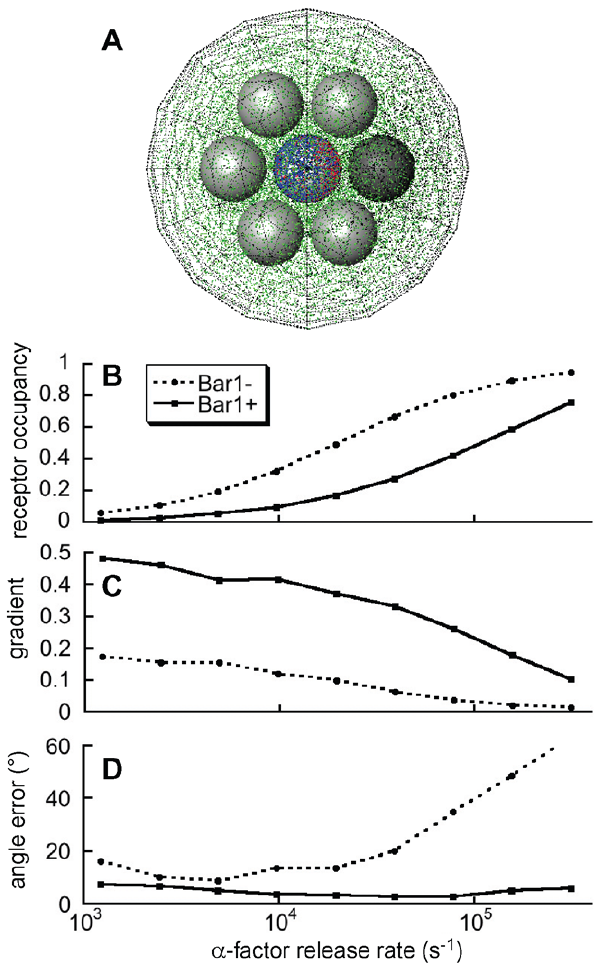
Figure 4. A model of the effect of the Bar1 protease on yeast signaling. (A) A snapshot of the system shown at steady state and with a target cell release of about 4 6 10 4 a -factor molecules per second. It is surrounded by a triangulated spherical boundary which absorbs molecules with Smoldyn’s ‘‘unbounded-emitter’’ method. The central sphere is a MAT a cell, light grey spheres are challenger MAT a cells, and the dark grey sphere on the right is the target MAT a cell. Blue dots are unliganded GPCRs, red are GPCR- a complexes, green are Bar1 molecules, and black are a -factor molecules. Model details are presented in Text S4. (B) Average receptor occupancy for Bar1 + and Bar1 – cells (see legend). These data fit well to Hill functions with unit cooperativity but with a 5- fold difference in their EC 50 s. (C) Average gradient of GPCR- a complexes across the surface of the MAT a cell. It is scaled so that 0 represents no gradient and 1 represents the maximum possible gradient. (D) Angle difference between vectors that point from the MAT a cell center to ( i ) the average position of the GPCR- a complexes and to ( ii ) the target cell center, averaged over all time points. This figure shows that although Bar1 decreases a -factor binding to the MAT a cell, it increases the MAT a cell’s ability to locate the target MAT a cell.